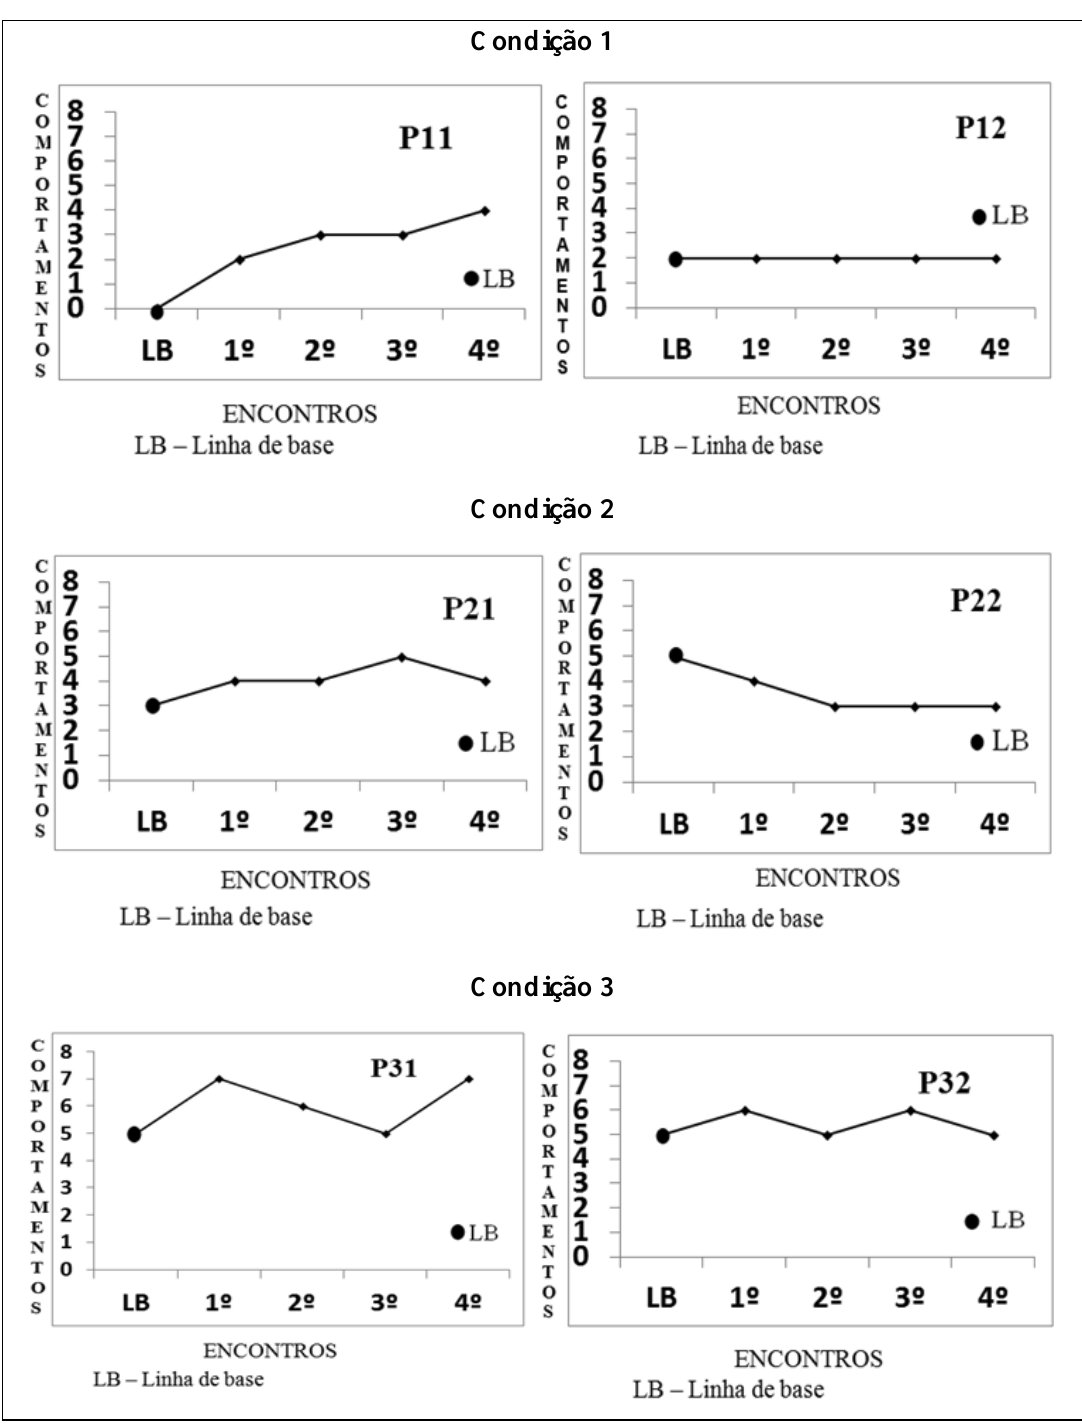
Figura 1 . Número de comportamentos adequados de cuidados com os pés ( N =8) apresentados na linha de base (LB) e nos quatro encontros pelos participantes das Condições 1 [P11 e P12] (com perguntas e com exame), 2 [P21 e P22] (sem perguntas e com exame) e 3 [P31 e P32] (sem perguntas e sem exame) do Experimento 1. não contribuíram para estabelecer os relatos de comporta- Os resultados do 4º encontro dos Participantes P12, participantes. Diferentemente, os resultados dos P22 e P32 sugerem que as manipulações experimentais (a apresentação do roteiro de perguntas e o exame dos pés)